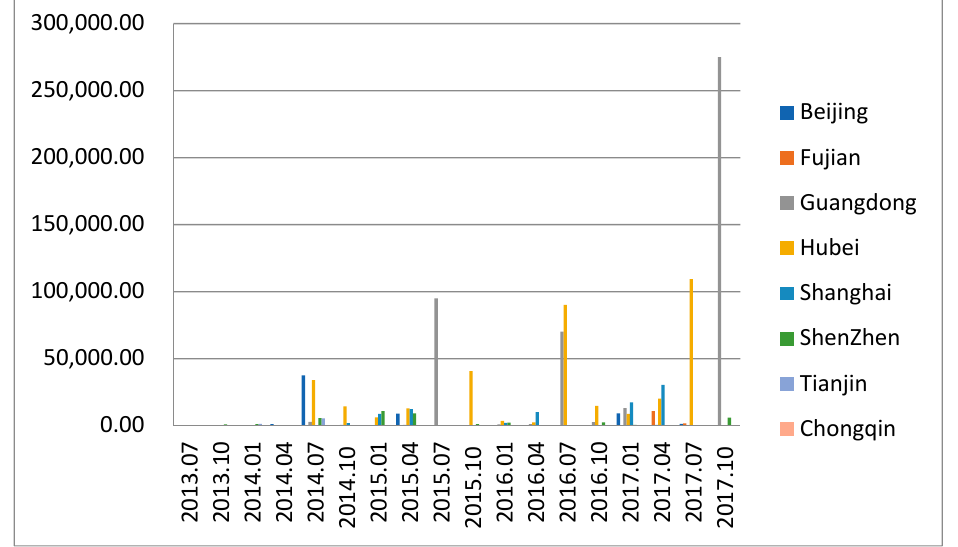
Figure 2. Trading volume in first trading day of each quarter during 2013 to 2017 in Chinese ETS pilots [55].